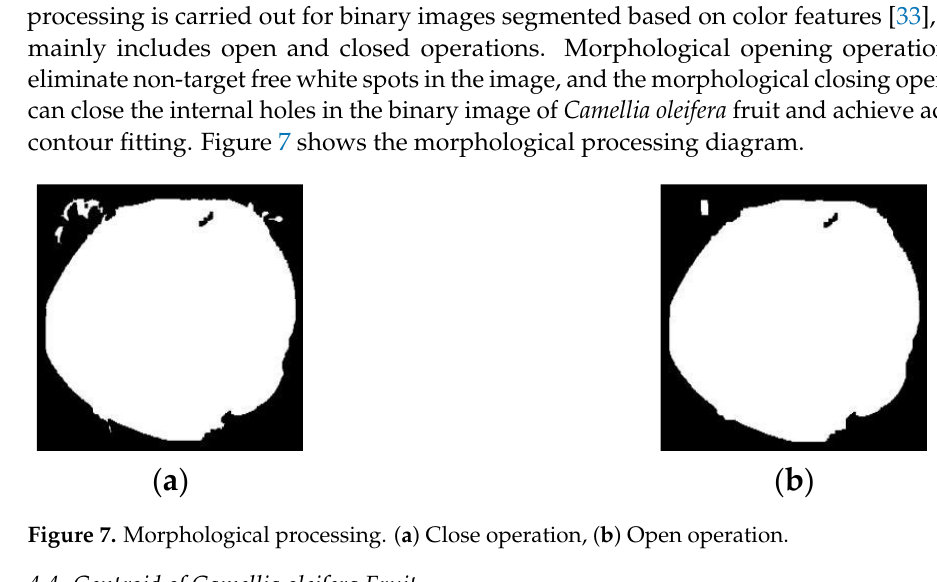
Figure 6. Image segmentation. ( a ) Based on HSV color space, ( b ) Based on gray scale factor.